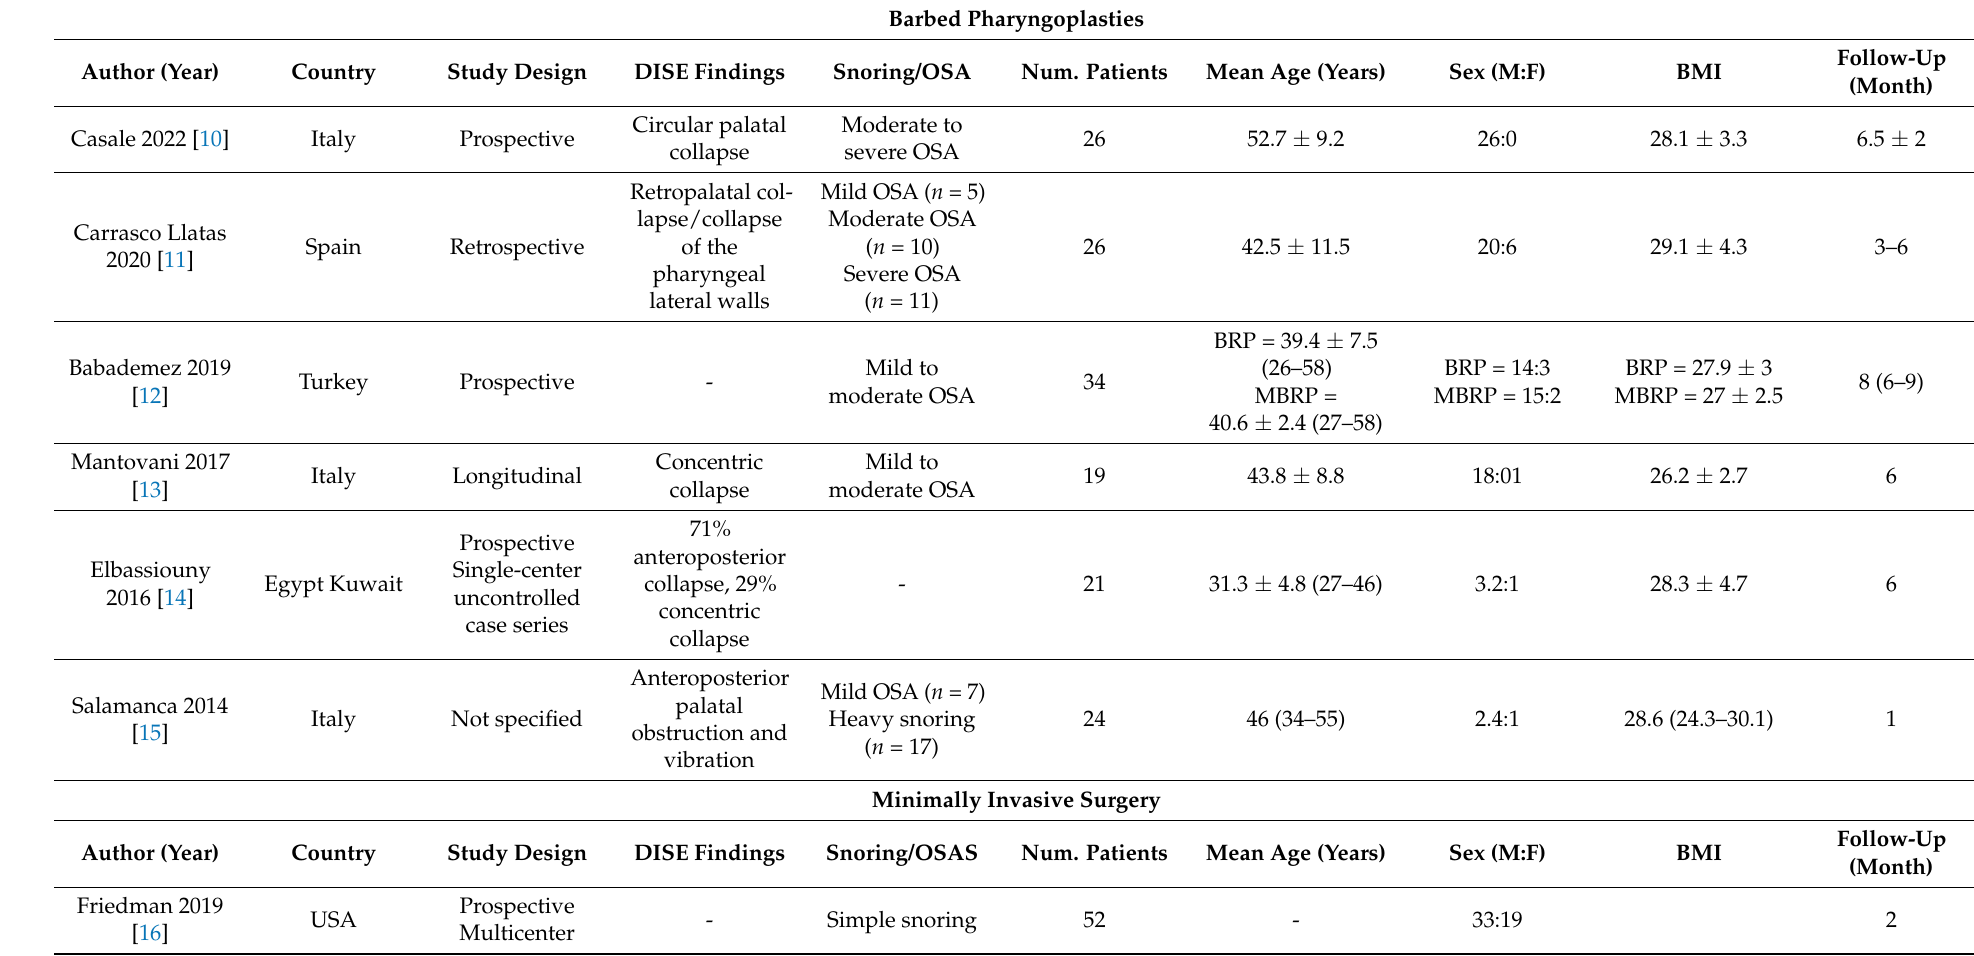
Table 1. General characteristics of the included